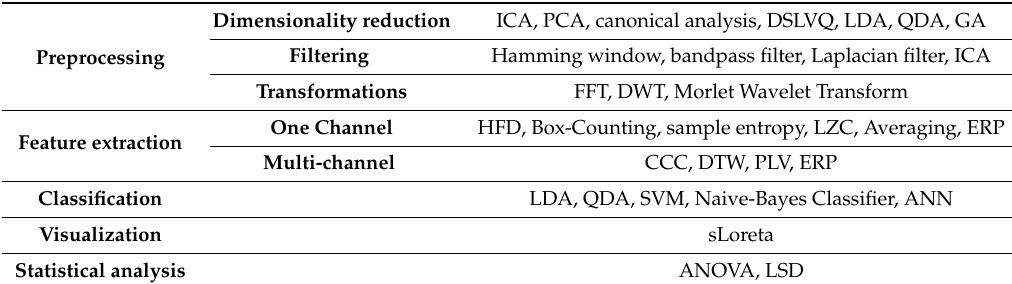
Table 2. A classification of the identified techniques based on for what they can be used.